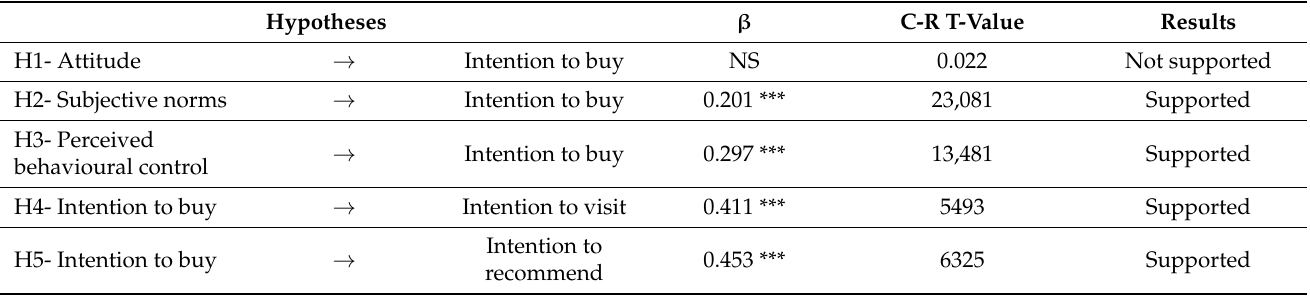
Table 5. The results for the structural